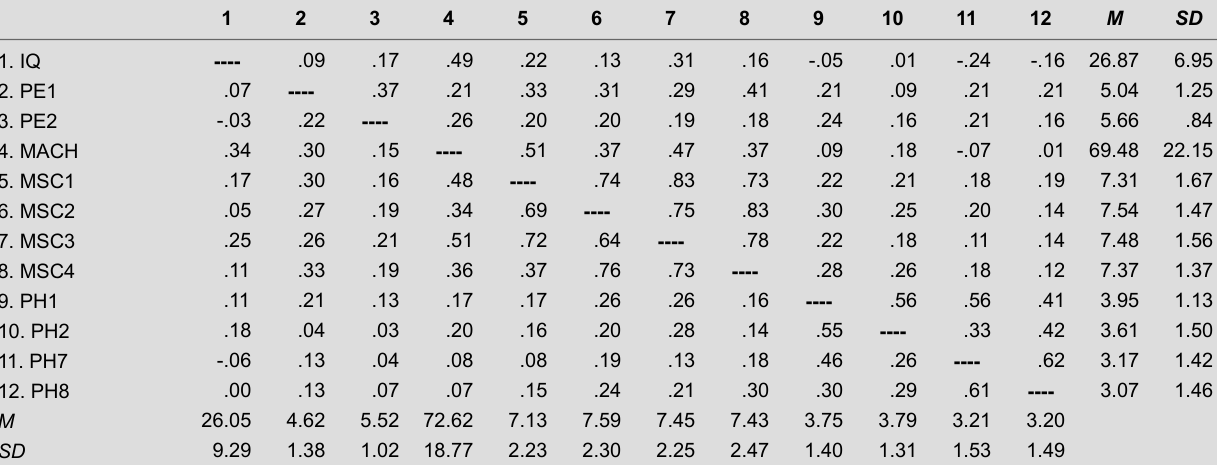
Zero Correlations, Means, and Standard Deviation of the Observed Study Variables